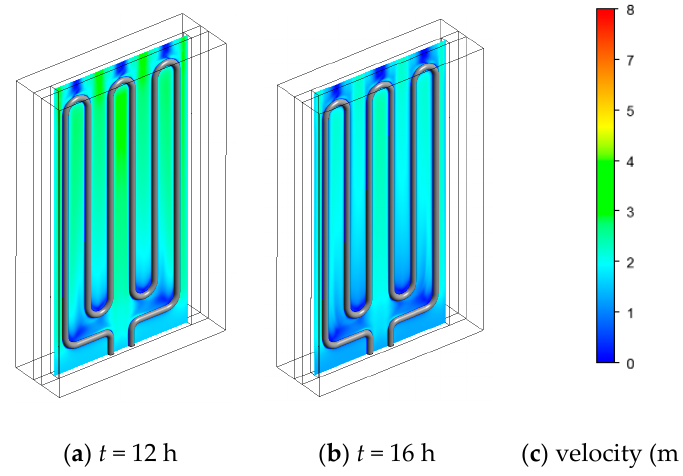
Figure 8. The velocity contours at the middle cross-section of the flow channel at different discharging time.